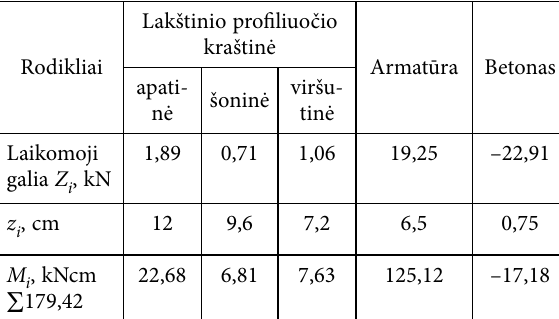
Table 11. Calculation of the moment resistance of one rib Lakštinio profiliuočio kraštinė Rodikliai